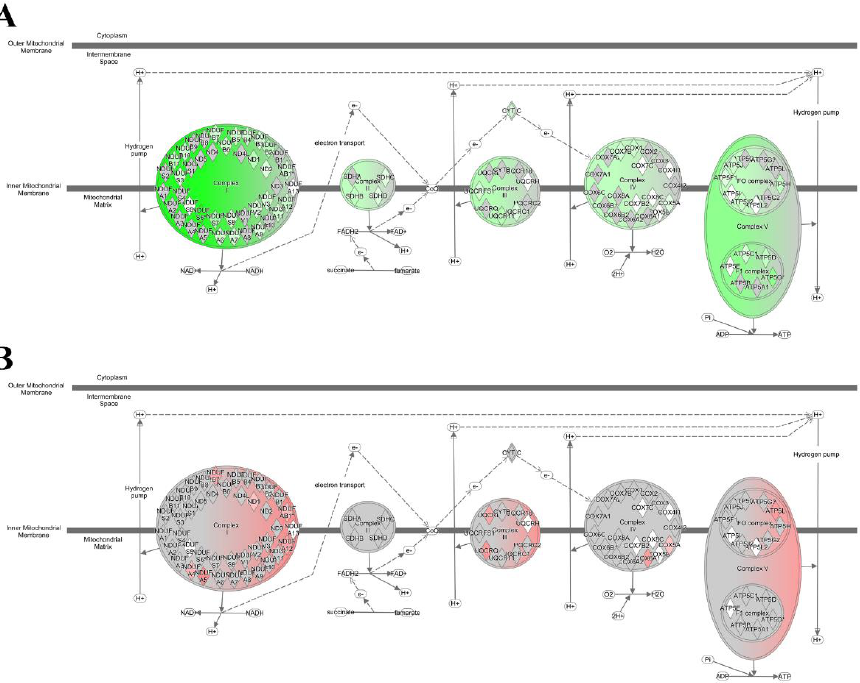
Figure 5. Anti-C5 treatment improves oxidative phosphorylation canonical pathway. ( A ) HFD feeding downregulates many genes involved in oxidative phosphorylation pathway, comparison: HFD+vehicle vs. Chow while ( B ) anti-C5 treatment upregulates a subset of oxidative phosphorylation genes, comparison: HFD+vehicle vs. HFD+BB5.1. Green: gene downregulation, red: gene upregulation.